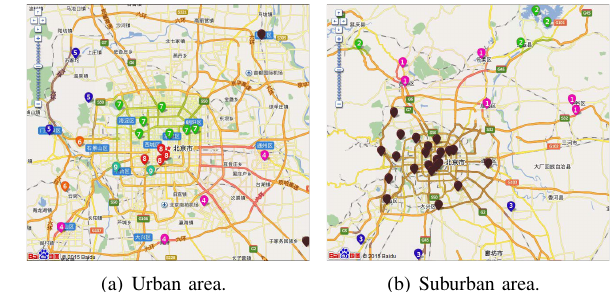
Fig. 5. Sub-netting results, counting frequency by II. B. 2). a), and clustering by K-means based on Affinity. Map provide by Baidu.com, Inc.